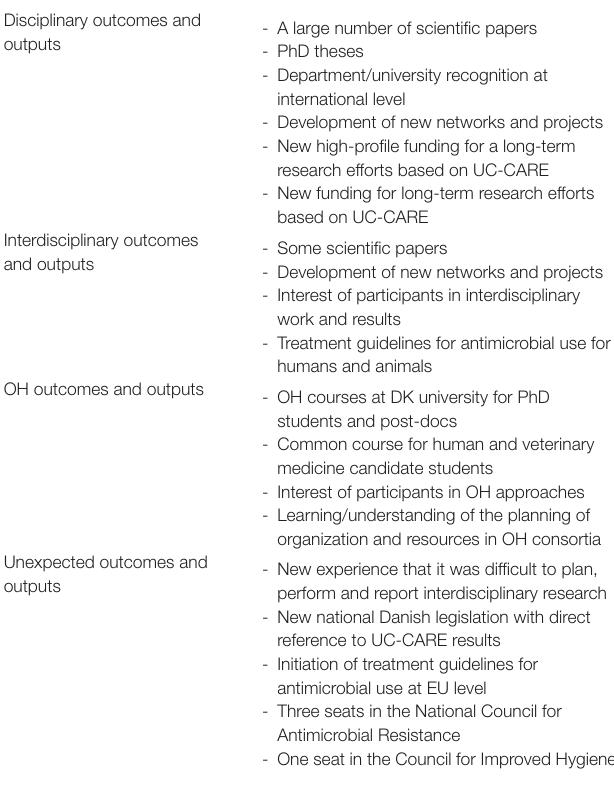
TABLE 1 | List of different outputs and outcomes of the UC-CARE project for the categories: disciplinary, interdisciplinary, OH and unexpected outcomes and